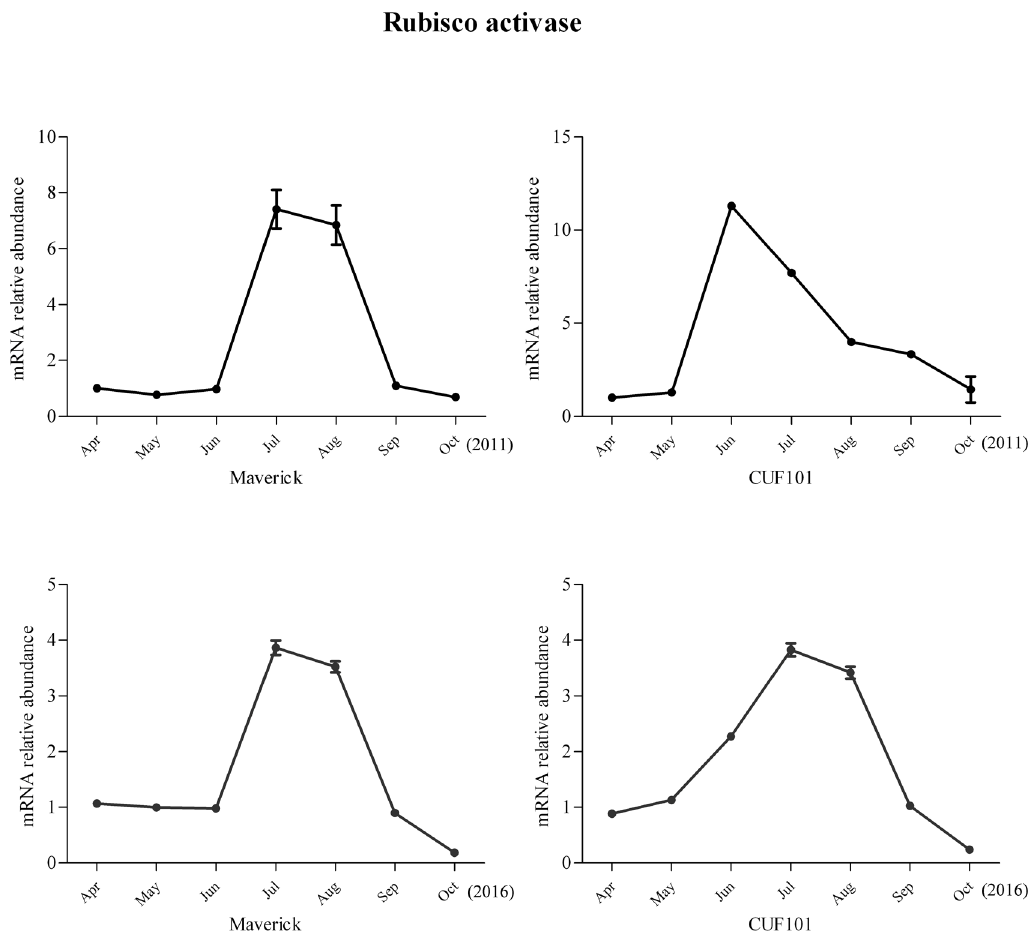
Fig 8. mRNA abundance of Rubisco activasein Maverick and CUF101varietiesfrom April to October in 2011 and 2016. ** indicatessignificantdifference betweenSeptember, October, July, and August at p < 0.01.